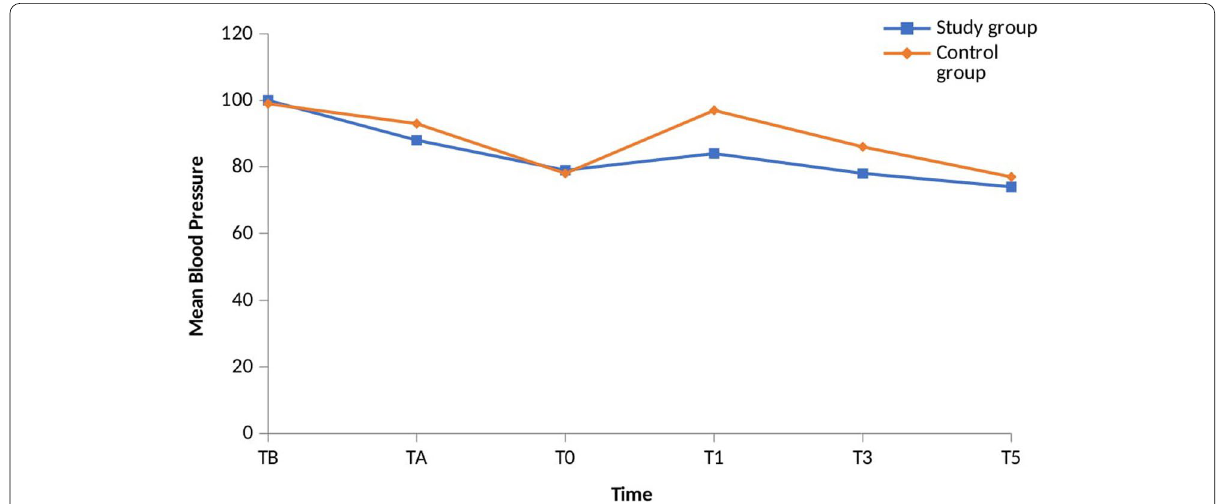
Fig. 3 Changes in mean blood pressure in both studied